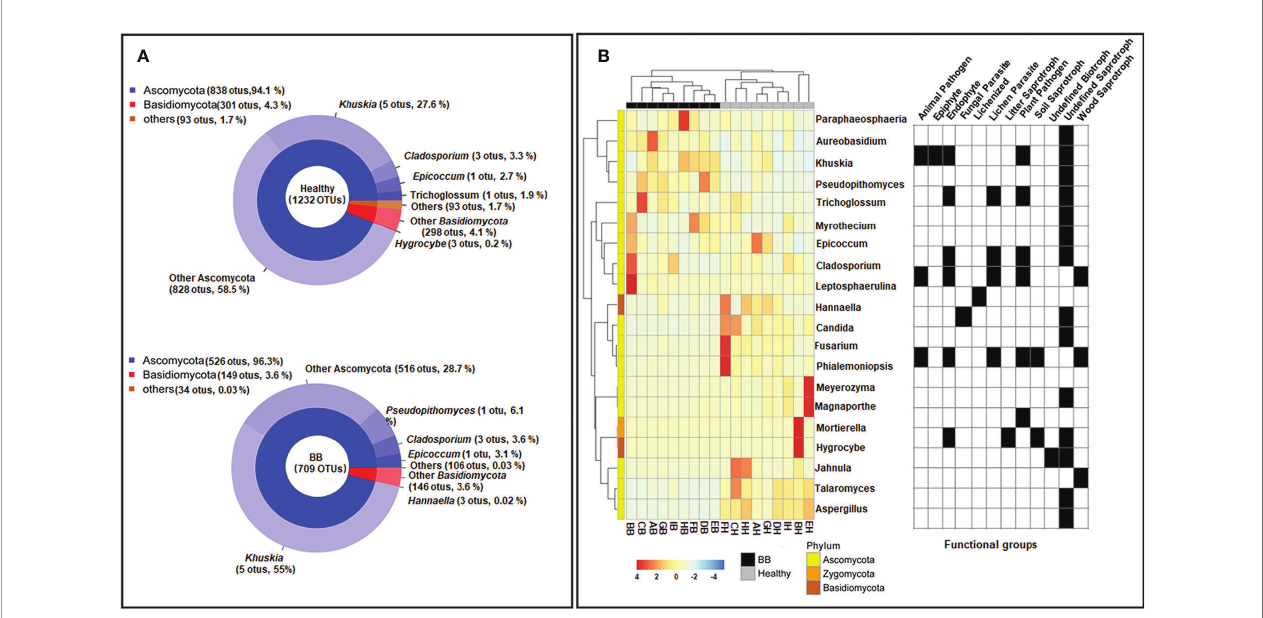
FIGURE 2 | Compositional structure of the endophytic fungal communities of rice leaves. (A) The relative abundance of fungal phyla (top) and genera (bottom). (B) Hierarchical clustering and annotation of the 20 most abundant fungal genera in healthy or symptomatic leaves, based on their relative abundance in healthy and BB-diseased rice leaves. The annotation panel on the right indicated the functional guilds each genus being assigned to by